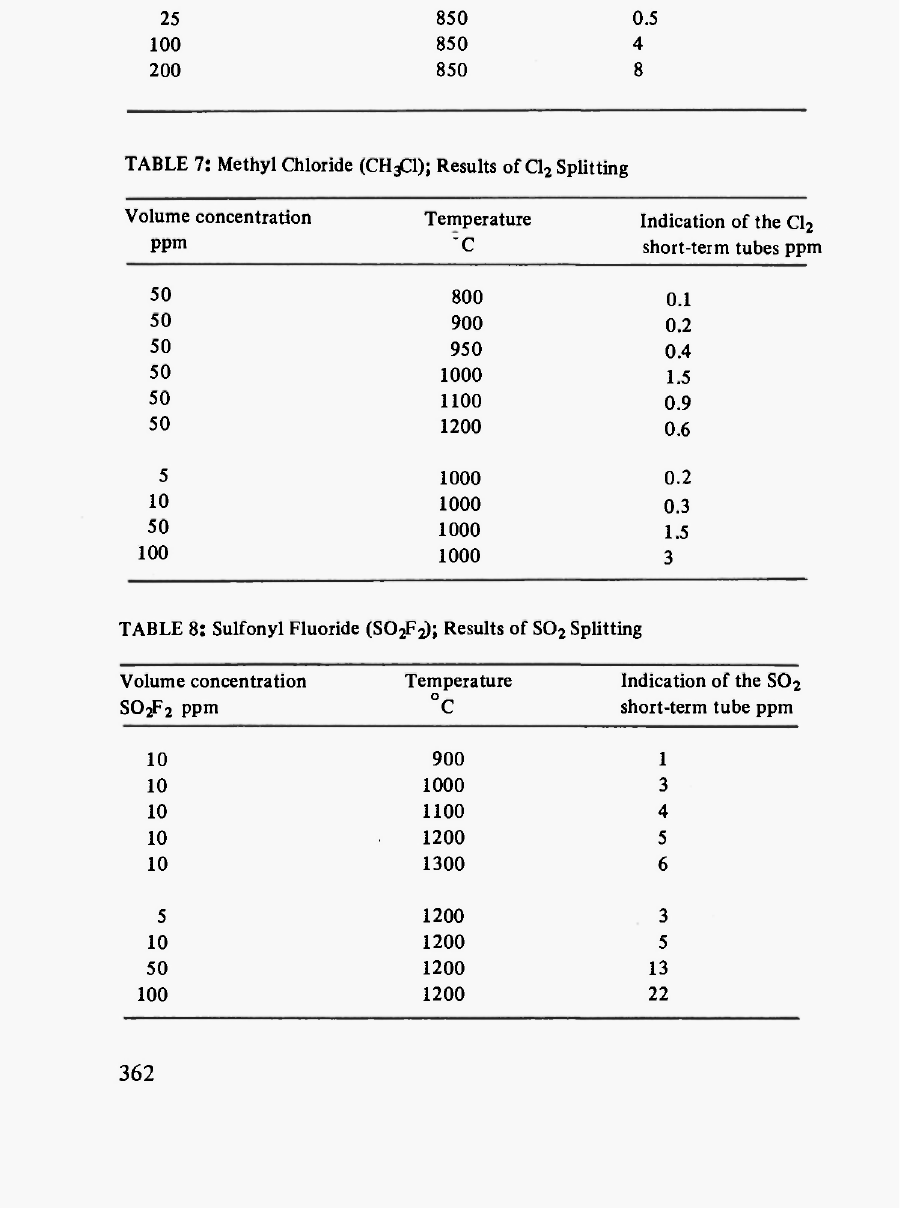
TABLE 7: Methyl Chloride (CHjCIl); Results of Cl 2 Splitting Volume concentration